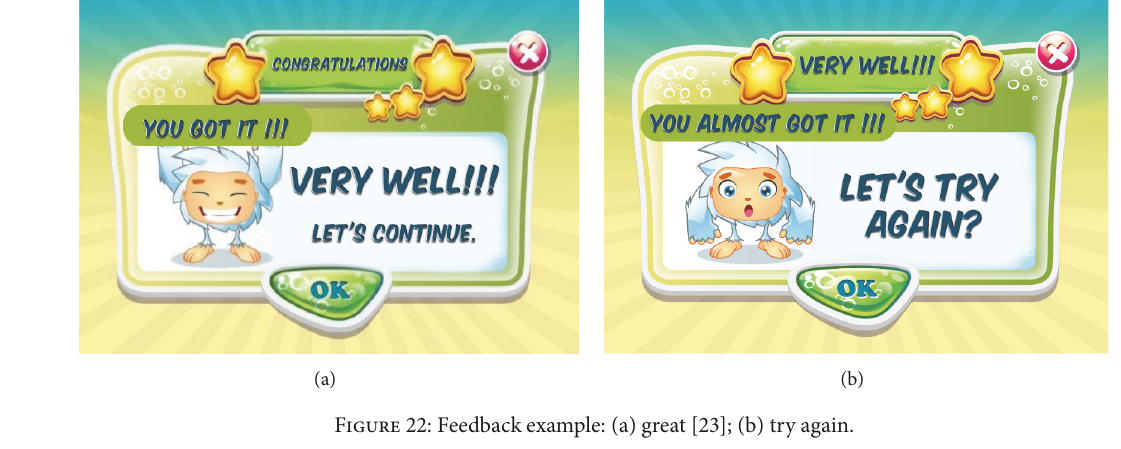
Figure 22: Feedback example: (a) great [23]; (b) try again.